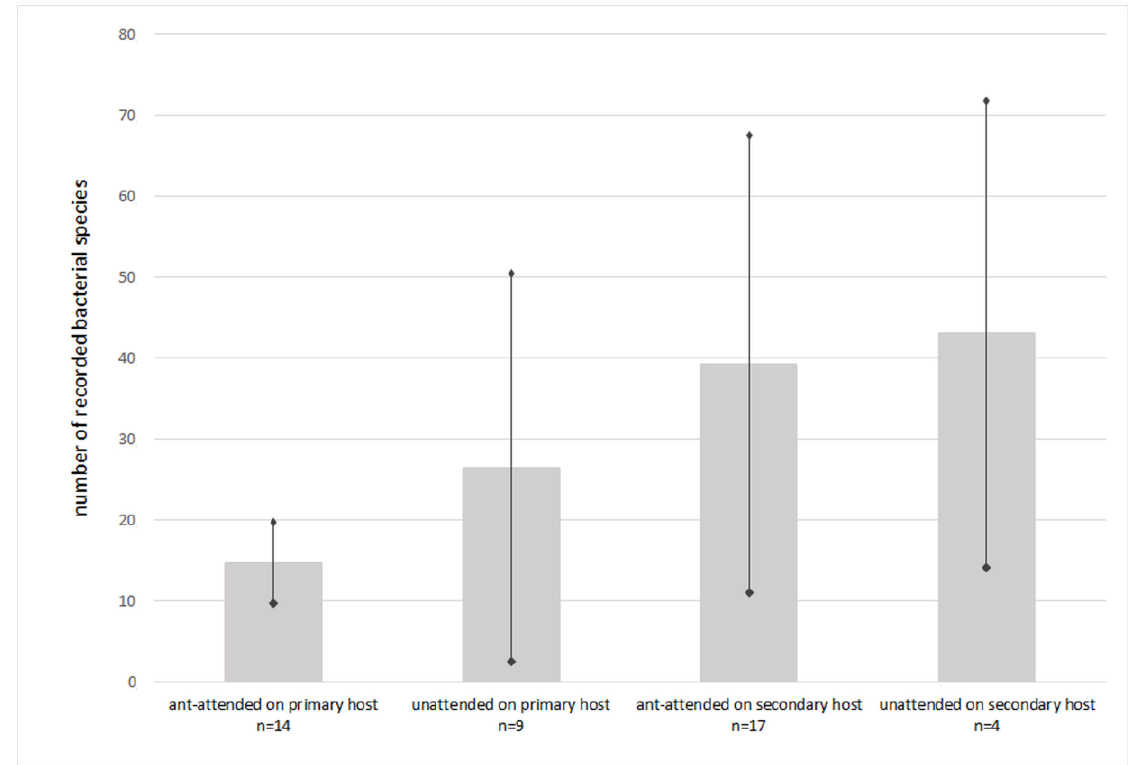
Figure 1. Mean number of bacterial species recorded in particular groups of samples (vertical bars indicate ±SD).